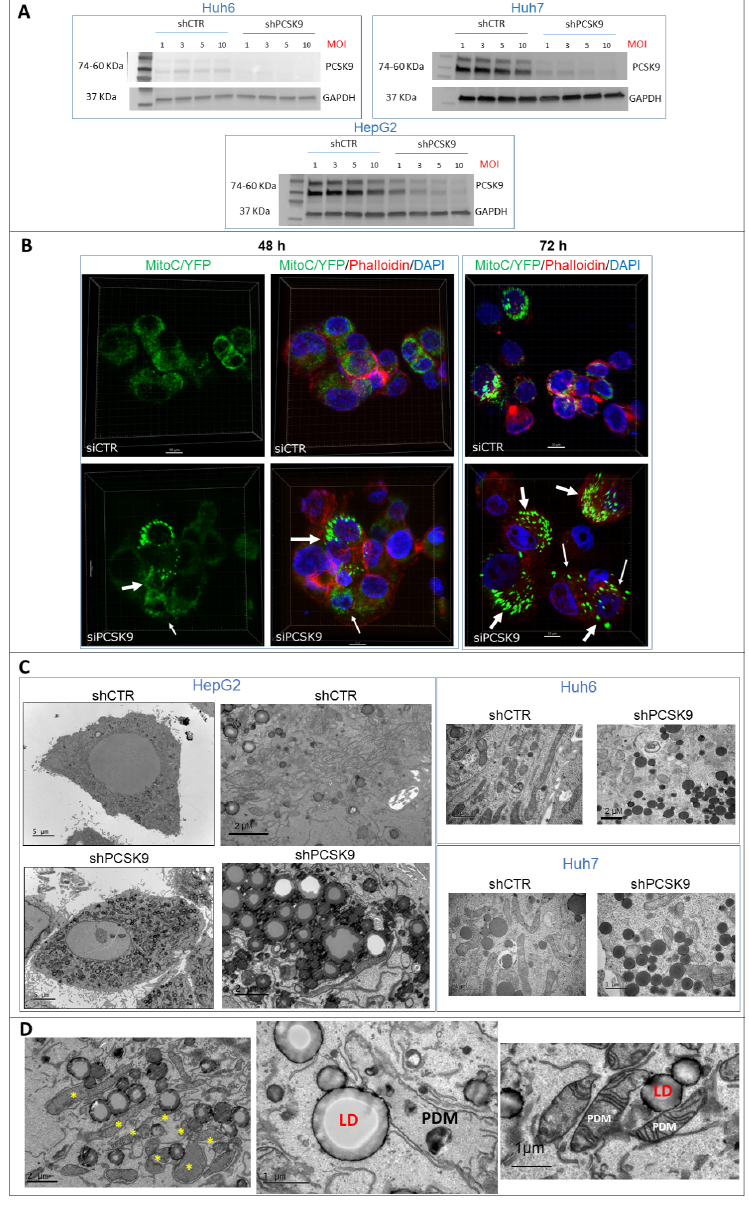
Figure 5. PCSK9 deficiency leads to intracellular accumulation of lipid droplets. ( A ) Validation of depletion of PCSK9 by shRNA silencing. Cell extracts were prepared after transduction with control shRNA (shCTR) or targeting PCSK9 (shPCSK9) of Huh6 or Huh7 or HepG2 cells. Different MOIs (multiplicity of infection) were tested: 1, 3, 5 and 10; the latter was picked for further experiments. A total of 40 µ g of cell proteins was loaded per lane on an SDS-PAGE. After electrophoresis and transfer, the membrane was analyzed by Western blot using anti-PCSK9 antibodies and GAPDH antibodies for comparison of loading. The two bands observed for PCSK9 correspond to the pro-PCSK9 (74 kDa) and cleaved PCSK9 (60 kDa). ( B ) Confocal microscopy observation of HepG2 cells performed 48 and 72 h after transfection with PCSK9 siRNA (si1) and siCTR. Mitochondria were labeled with C/YFP using a specific lentivirus targeting system (MitoC/YFP). Phalloidin (red) and DAPI (blue) were used for microfilament and nuclear DNA staining, respectively. Arrows indicate bright mitochondria network observed more frequently when PCSK9 is silenced. ( C , D ) Transmission electron